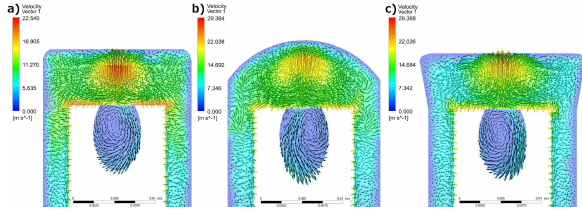
Figure 11: Distribution of liquid velocity on the model lateral plan: (a) rectangular profie, (b) semi-circular profie and (c) trapezoidal